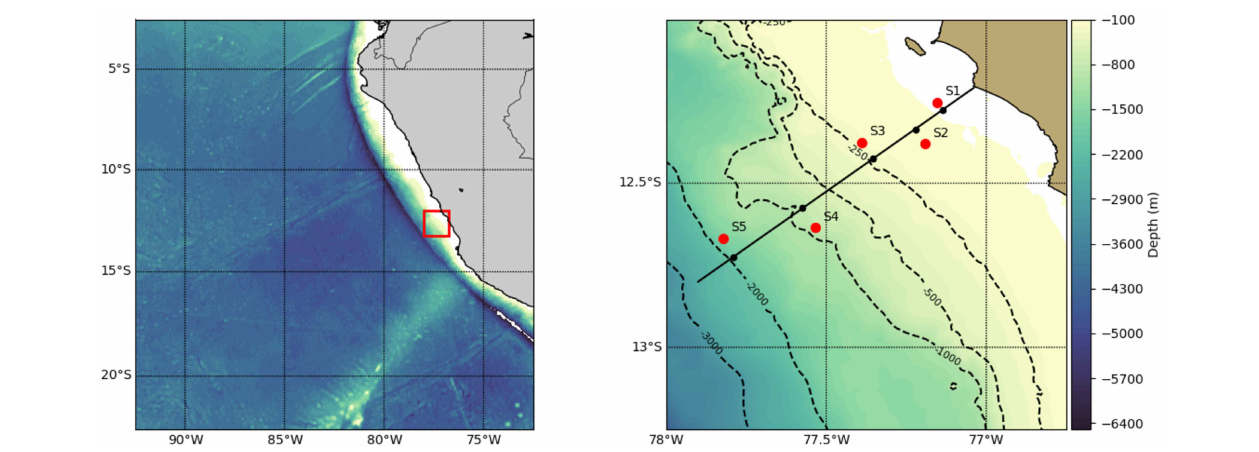
FIGURE 1 | Map of the Eastern Tropical South Pacific (left) with a red rectangle indicating study area (right) and red dots indicating sites (S1–S5). At each of the five sampling sites, a pair of day and night hauls were obtained.